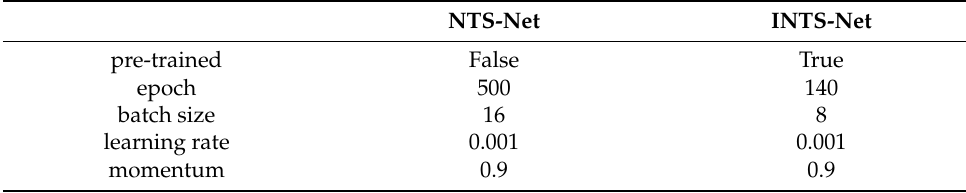
Table 1. The comparison of partial hyperparameters.